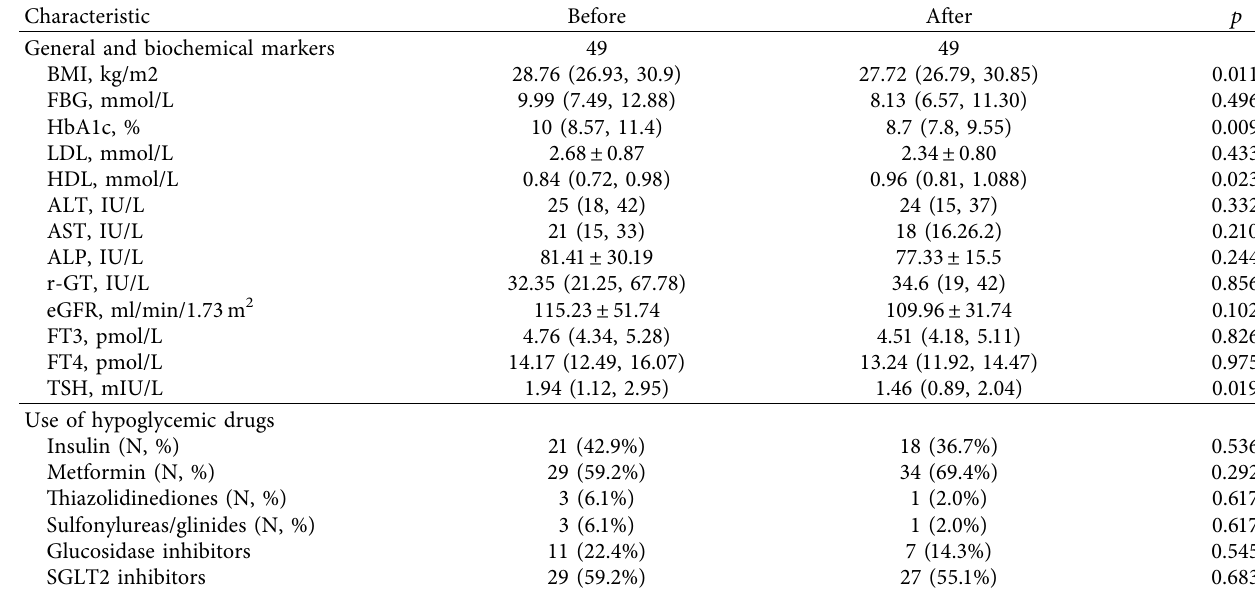
Table 2: Metabolic characteristics of patients with type 2 diabetes and nonalcoholic fatty liver disease by liraglutide use. Characteristic Before After p General and biochemical